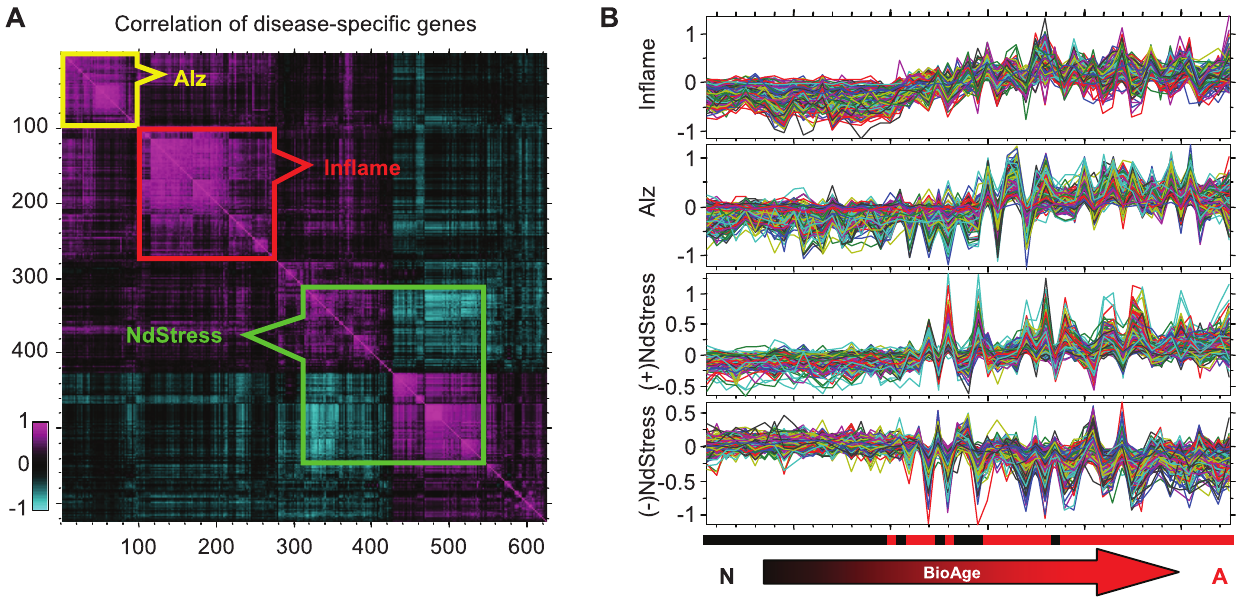
Figure 3. Disease-specific metagenes. (A) Clustered gene-gene correlation matrix demonstrating strong mutual correlations between genes that were differentially expressed between AD and non-demented samples from PFC1. Three outlined clusters correspond to NdStress, Alz, and Inflame. The coregulation of these genes is also shown in the panel (B). Each colored line represents expression levels of individual genes in 55 PFC1 samples from non-demented and AD subjects sorted in the order of increasing BioAge. Only representative samples that scored in the top or bottom 3% for any of the biomarkers were selected for this figure to improve visualization.